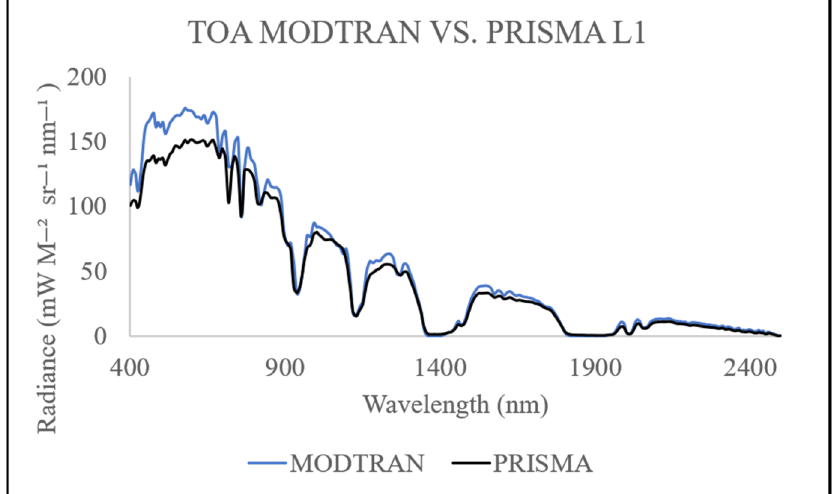
Figure 9. Radiance comparisons. TOA radiance from PRISMA L1 vs. MODTRAN simulation.